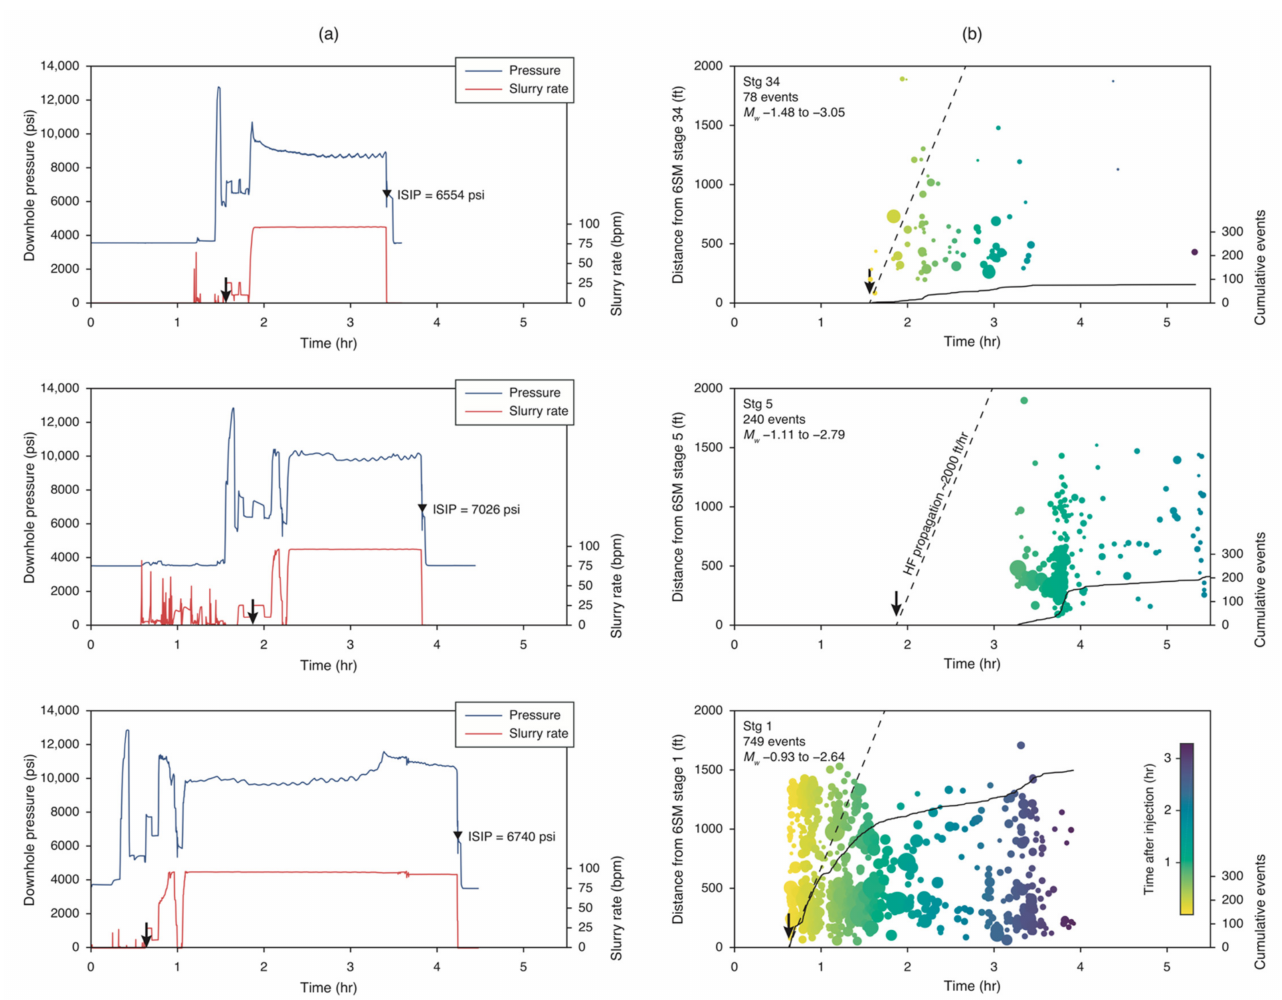
Figure 9. Relationships between hydraulic stimulation and microseismicity. ( a ) Pressure–rate–time plots for well 6SM Stages 1, 5, and 34. Black arrows indicate origin point for injection. ISIP values are indicated by black triangles. ( b ) Microearthquake distance-plots for well 6SM Stages 1, 5, and 34. Points are sized by magnitude and colored by time after injection. The dashed line indicates an average hydraulic fracture propagation velocity, ~2000